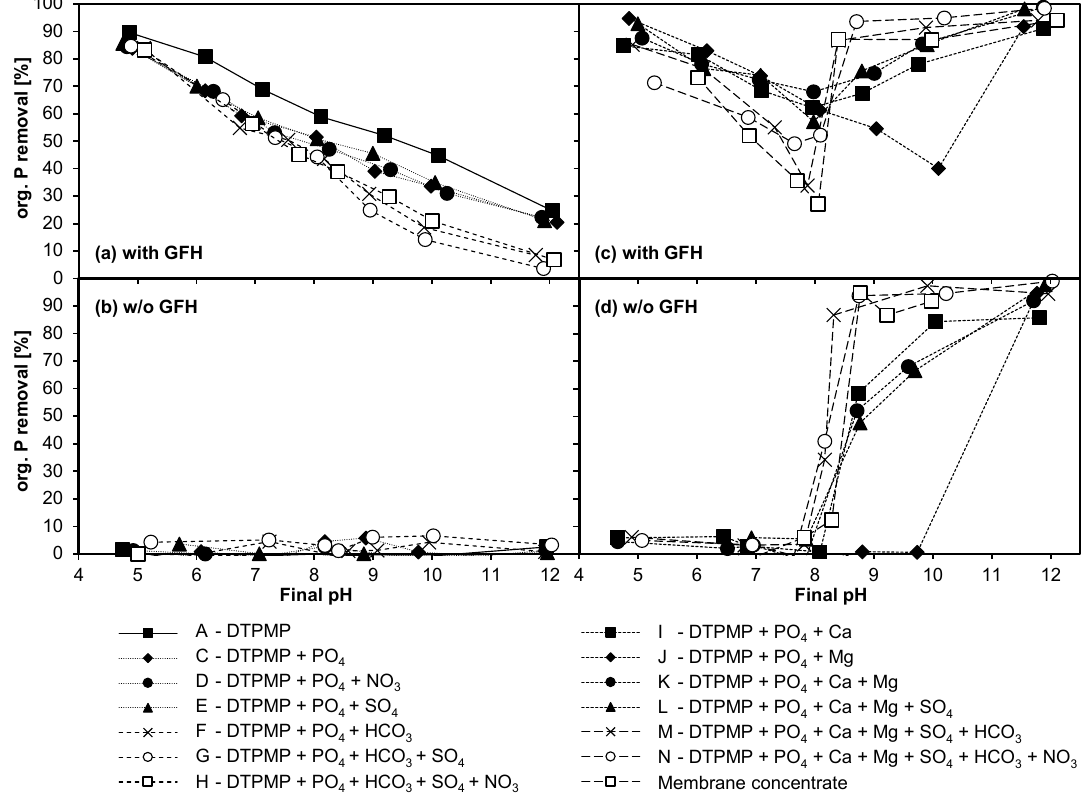
Figure 4. Organic P removal from synthetic replicas and real membrane concentrate (T = 20 °C; t c = 7 d; initial concentrations: see Chapter 2.3; 0.1 g GFH/L and without GFH). ( a ) solutions A, C-H with GFH, ( b ) solutions A, C-H without GFH, ( c ) solutions I-N and membrane concentrate with GFH, ( d ) solutions I-N and membrane concentrate without GFH.